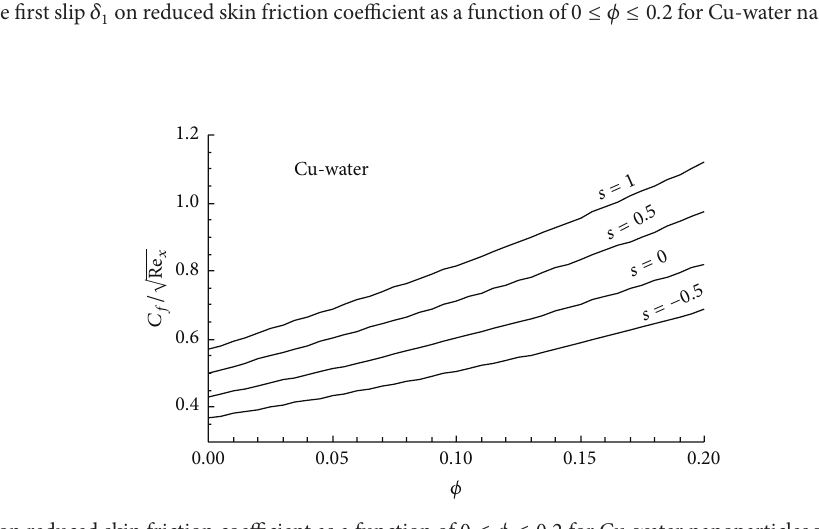
Figure 9: Effect of 𝑠 on reduced skin friction coefficient as a function of 0 ≤ 𝜙 ≤ 0.2 for Cu-water nanoparticles when 𝑃𝑟 = 6.2 , 𝛿 1 = 1 , and = 0 . 𝛿 2